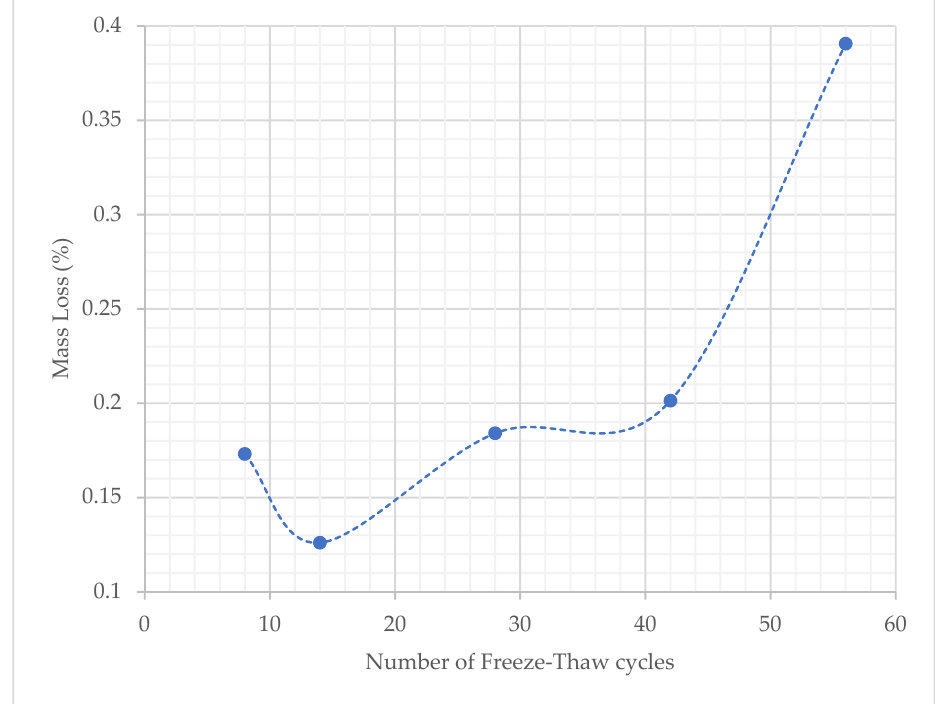
Figure 11. Mass loss (%) vs. Number of Freeze–Thaw cycles.